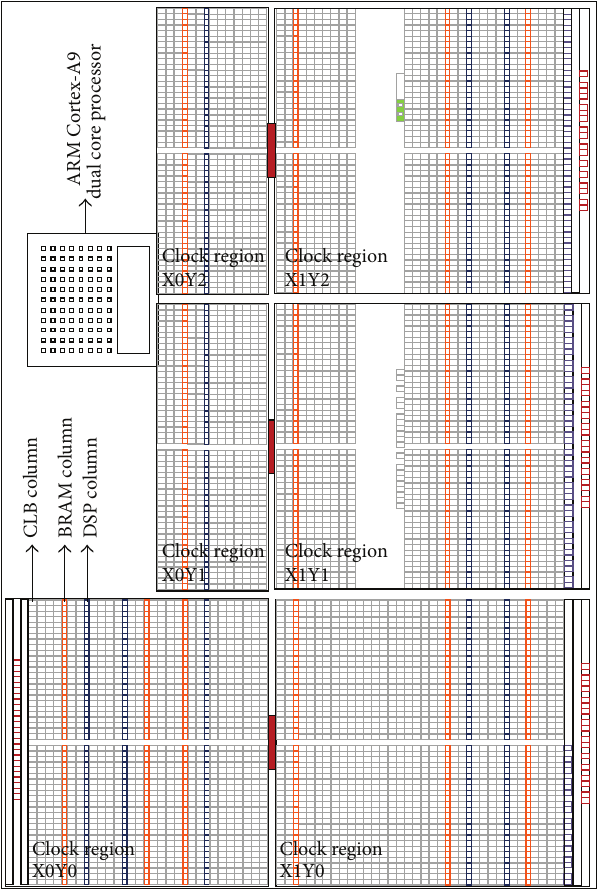
Figure 3: Column based FPGA architecture: